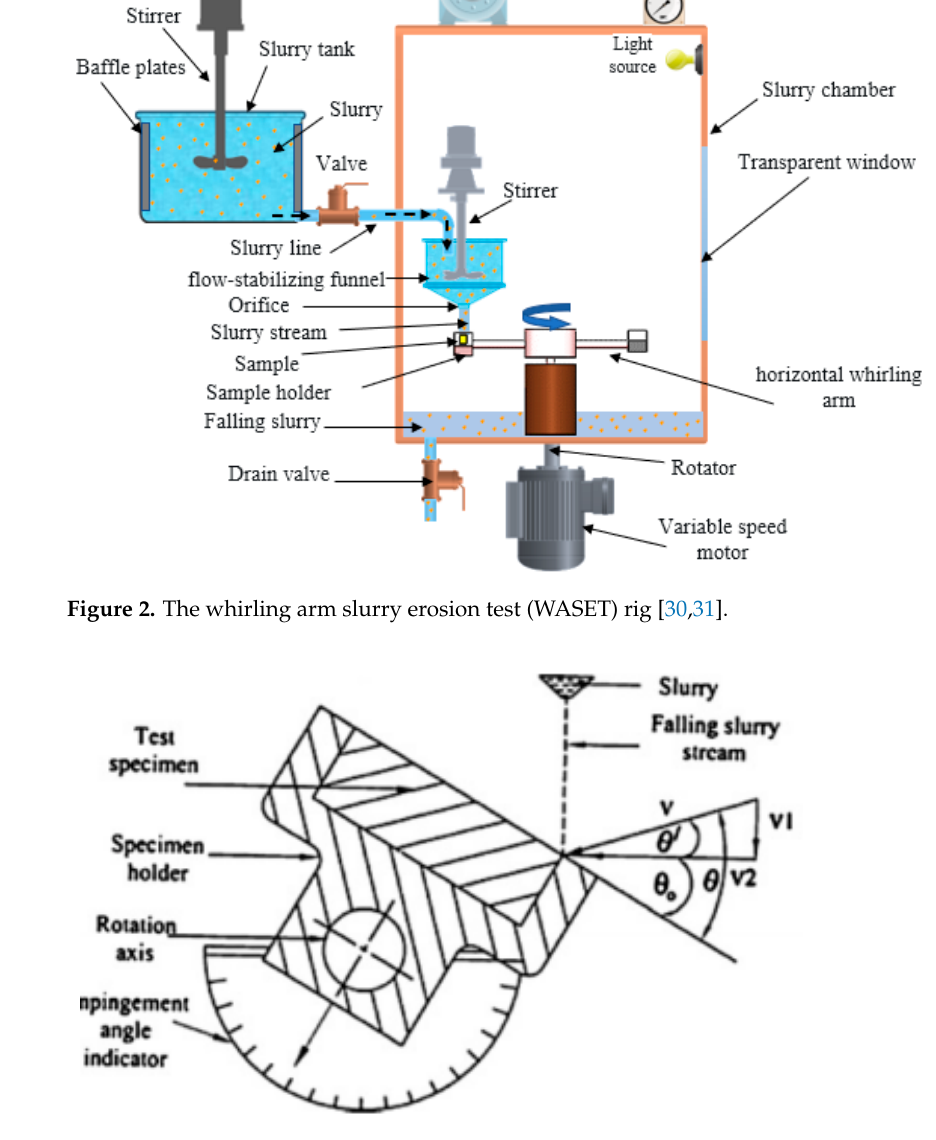
Figure 3. A schematic diagram of the impact angle and impact velocity of the test [32].